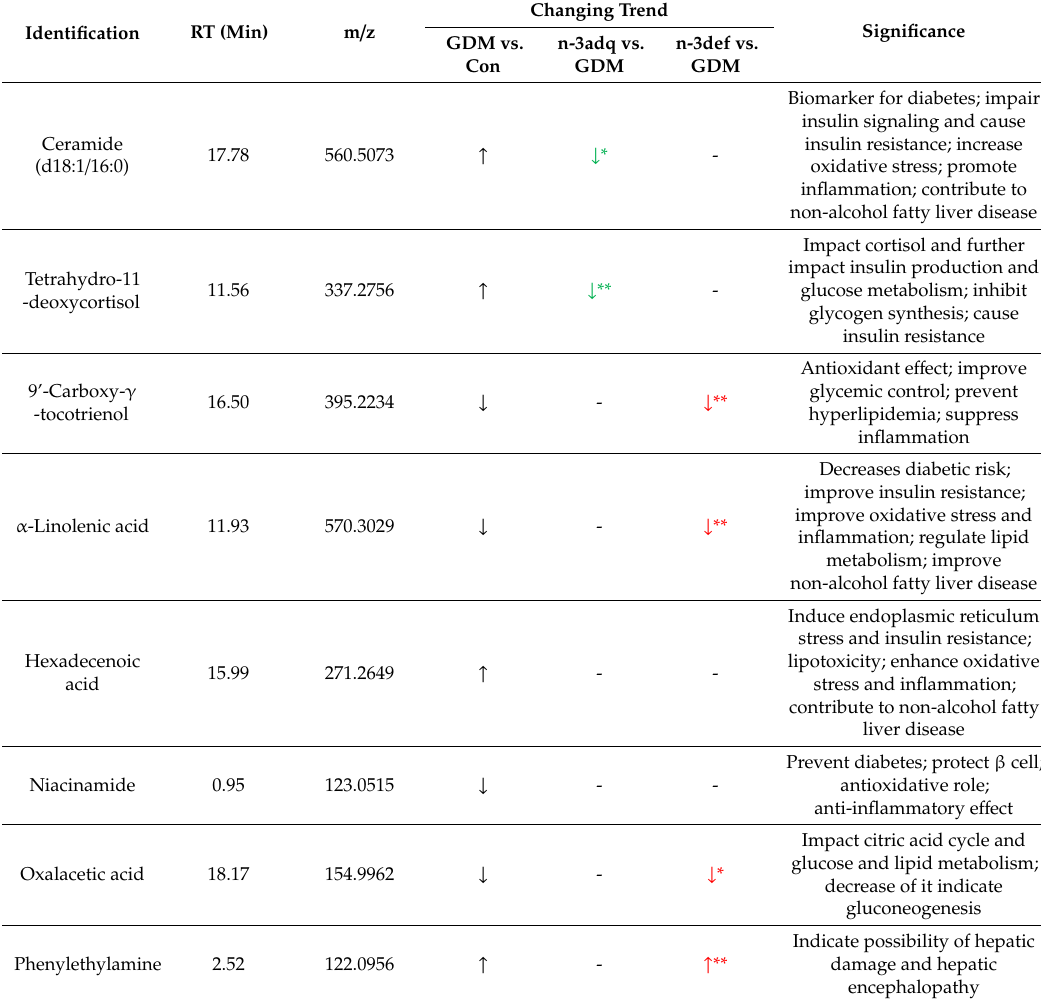
Table 3. Representative metabolites altered in the liver of gestational diabetes mellitus (GDM) o ff spring at 11 months of age and the e ff ects of n-3 polyunsaturated fatty acids ( n -3 PUFA) and n -6 PUFA on